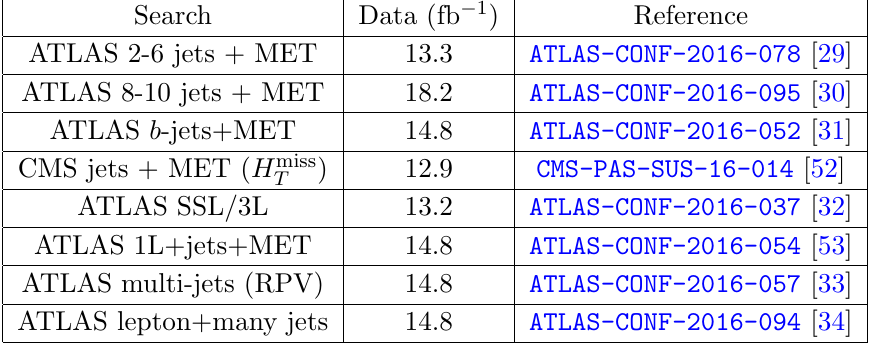
Table 1 . Searches most important to our study. All use the 13 TeV LHC